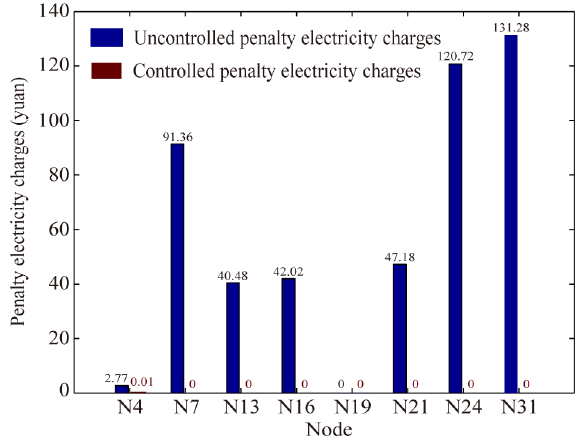
Figure 13. Penalty electricity charges of each user.